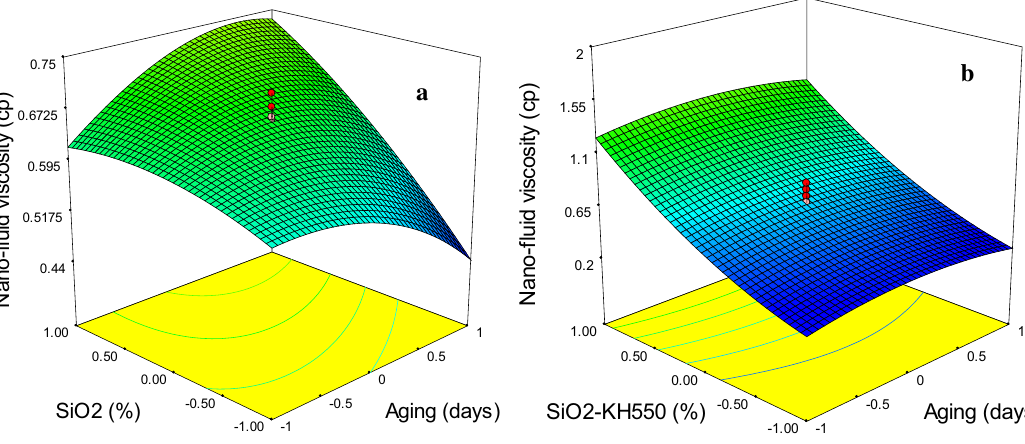
Fig. 4 Effect of aging time on the NF’s viscosity with the axis of SiO 2 and SiO 2 -KH550 represents concentration presented in terms of the coded value which indicate the lowest value to be 0.1% (− 1) and the highest 0.5% (1.0), while for aging is the number of days from 3 (− 1) to 15